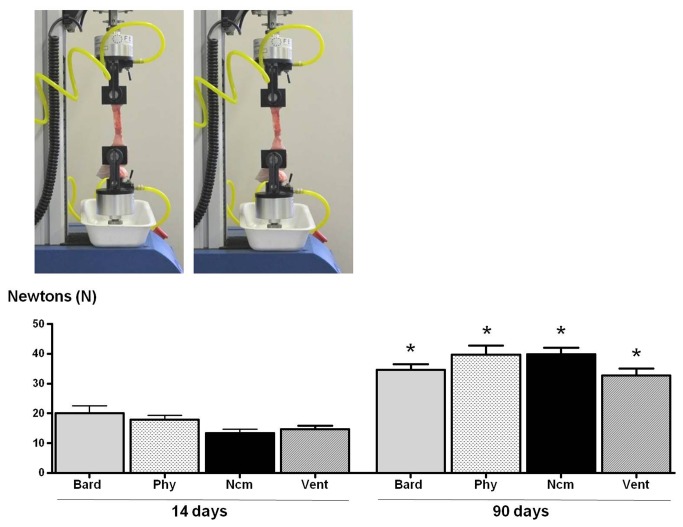
Biomechanical strength of the different meshes.Ultimate tensile strength of the different groups at 14 and 90 days postimplant. Bard meshTM (Bard), PhysiomeshTM (Phy), new composite mesh (NCM), VentralightTM (VL). (*p<0.05 versus 14 days).